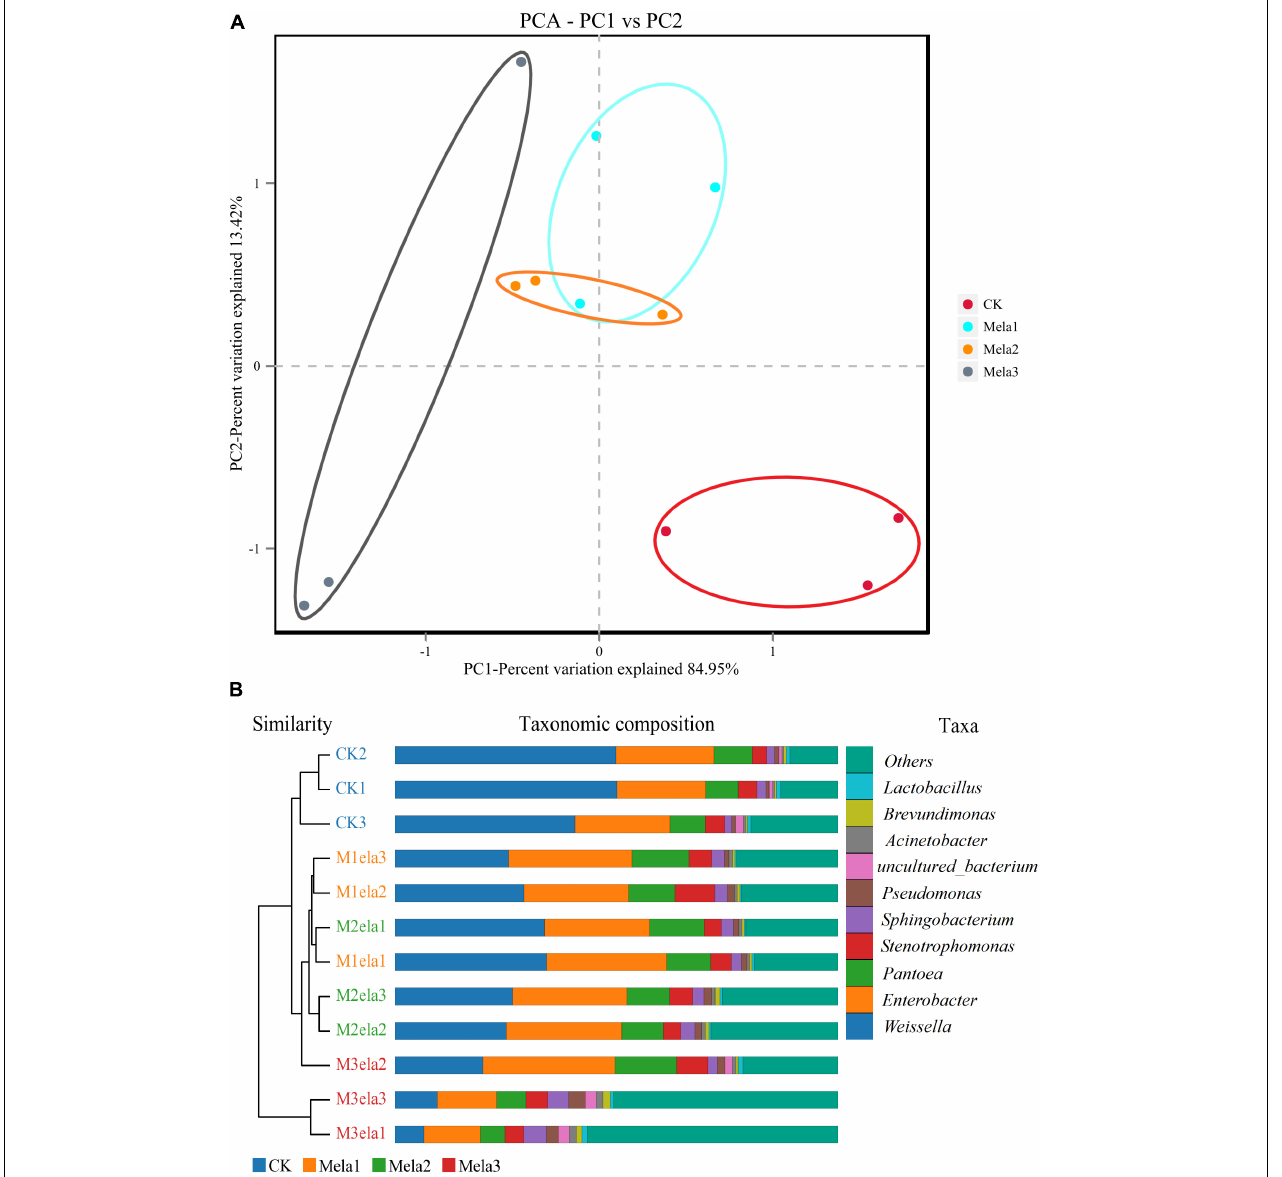
FIGURE 2 | Beta-diversity of bacterial diversity of stylo silage supplemented with melatonin ( n = 3).